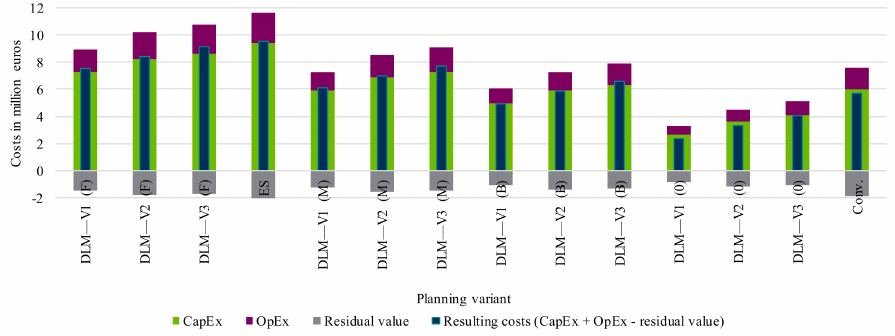
Figure 33. Resulting costs (CapEx + OpEx—residual values) consolidated over all analyzed variants for 18 low-voltage grids in different variants of dynamic load management based on [41].